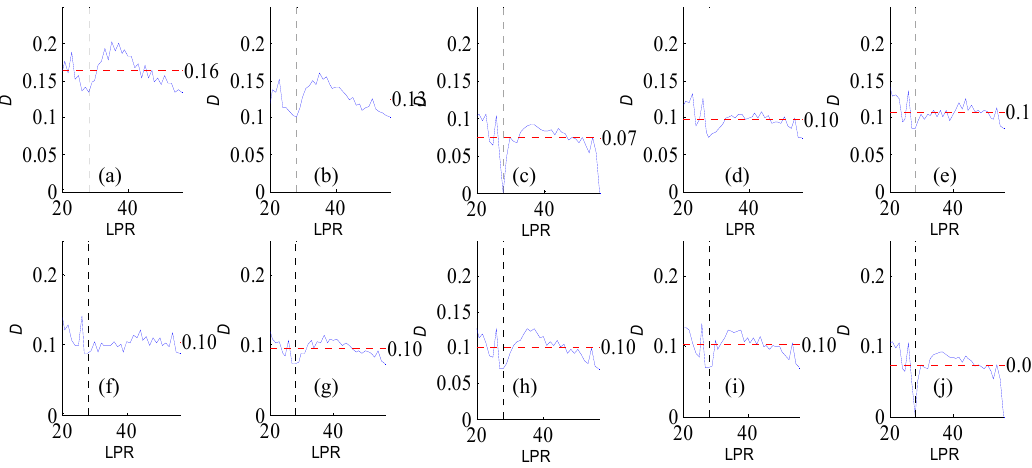
Figure A8. Variation of flow regime alteration degree (D) measured by the RVA with change in the length of post-impact flow time series (LPR) under a periodicity of 28 years. ( a – j ) correspond to pre-impact flow time series length = 20, 24, 28, 32, 36, 40, 44, 48, 52, and 56 years, respectively. The abscissa value for the vertical dotted line is 28. The ordinate value for the horizontal dotted line is the mean degree of flow regime alteration in each subfigure.